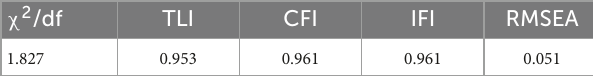
rate was 63.499%. Besides, the factor load of each item after the orthogonal rotation of the maximum variance method was between 0.707 and 0.890 (see Table 2 ). Exploratory factor analysis of PH was carried out, and the variance weight of factors was 51.854 and 48.146%, respectively.